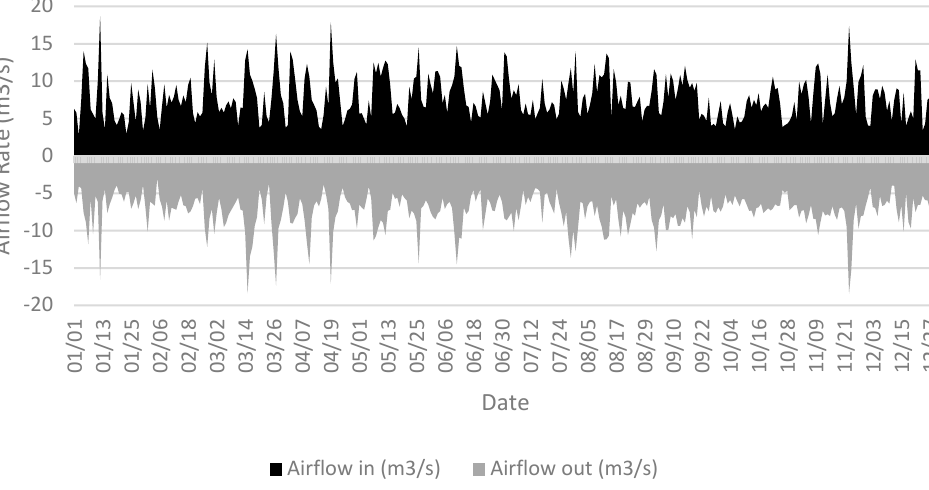
Figure 3. Average daily air volume flow rate out and into the building.